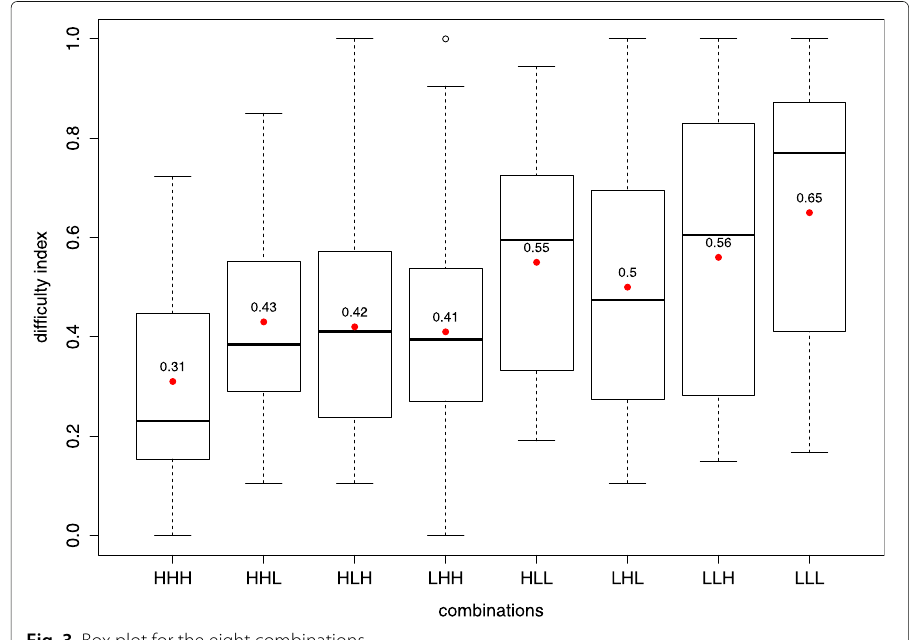
Fig. 3 Box plot for the eight